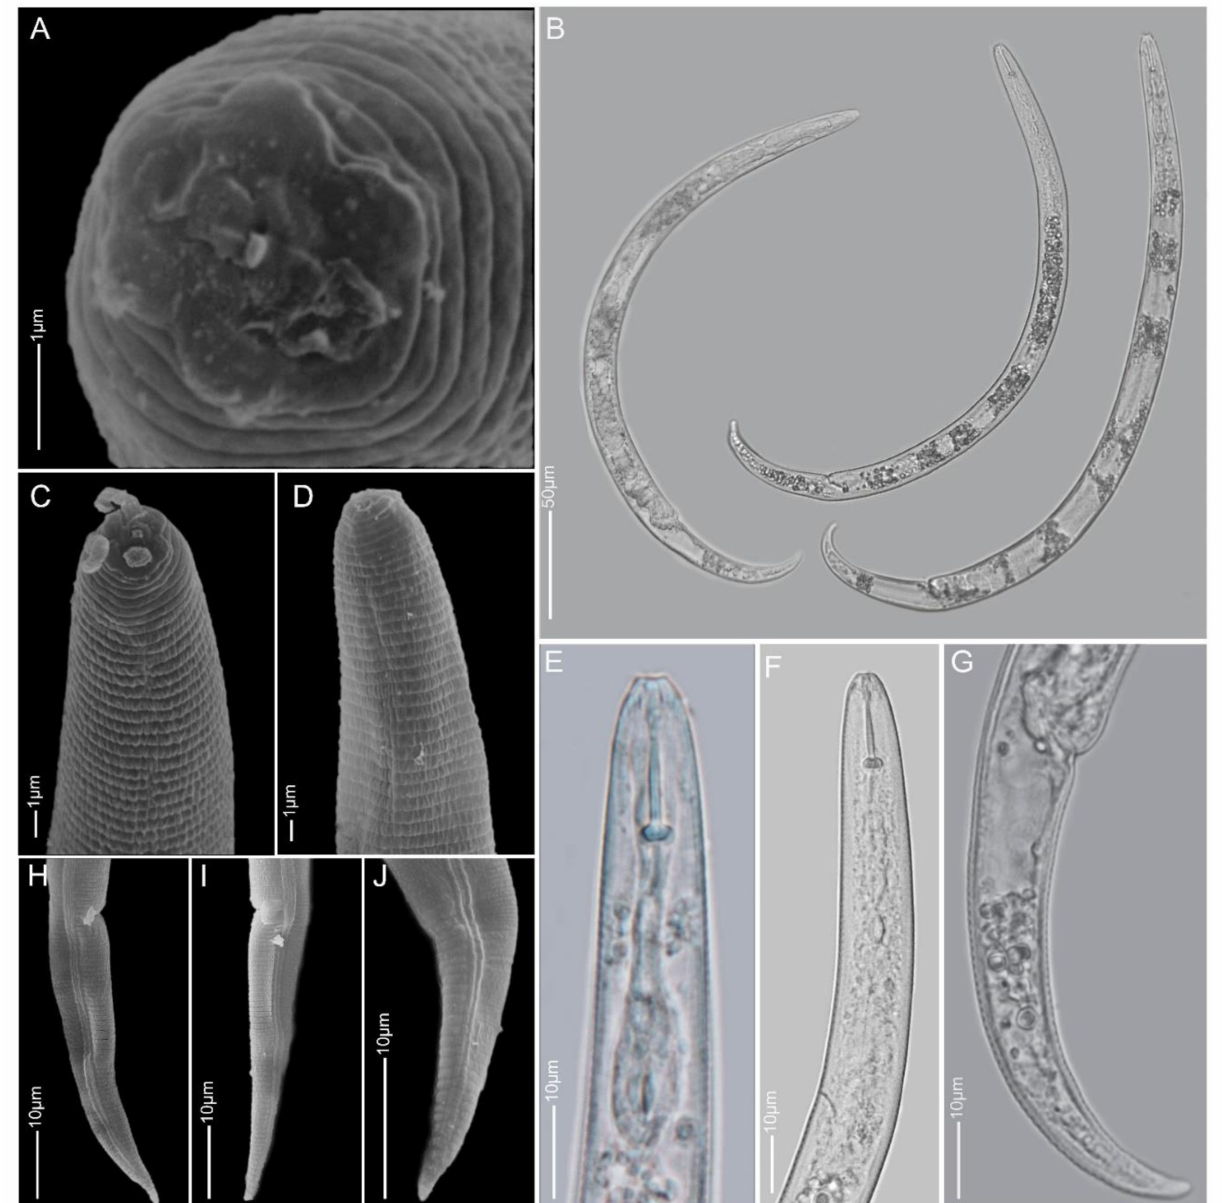
Figure 7. Light and scanning electron microscopy images of Paratylenchus microdorus females: ( A ) face view; ( B ) total body; ( C – F ) anterior region; ( G – J ) tail